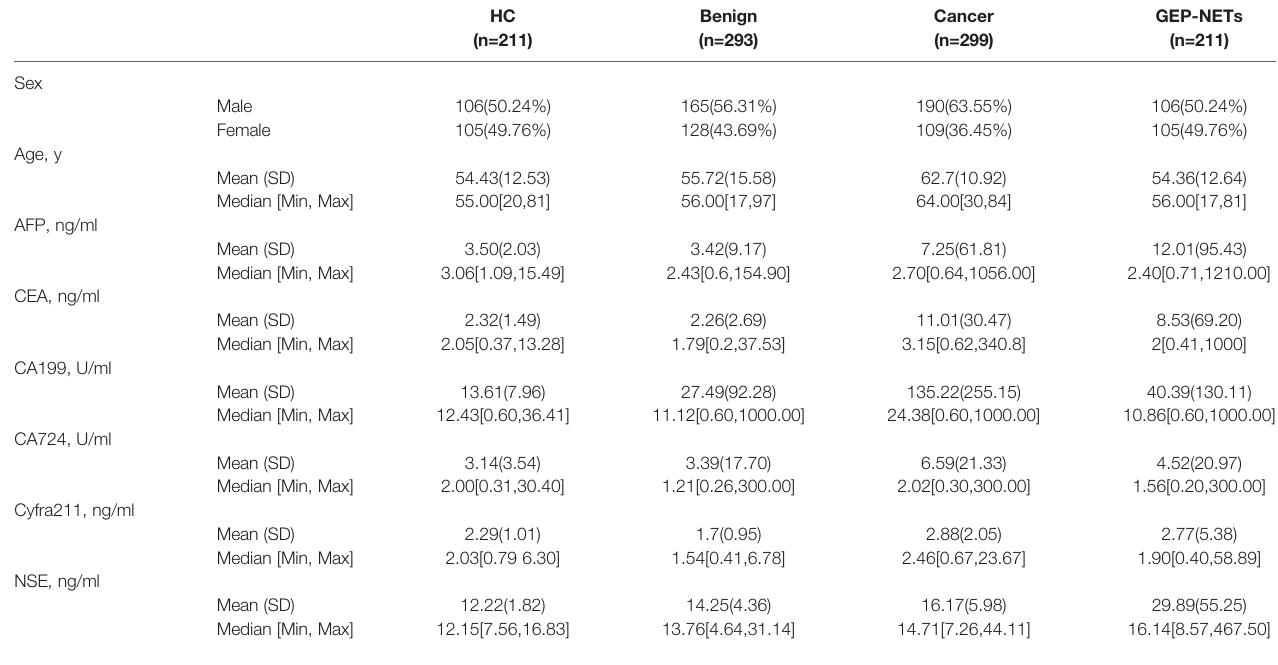
TABLE 1 | Characteristics of participants in four